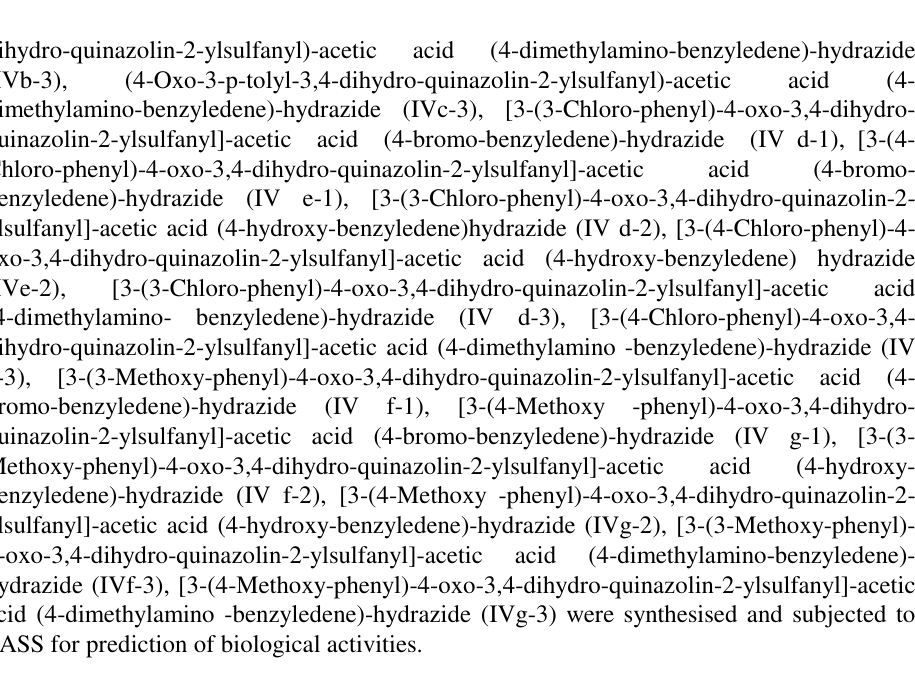
Table 5 . General characteristics and elemental analysis data of the compounds IV (a-g)(1-3) Compound